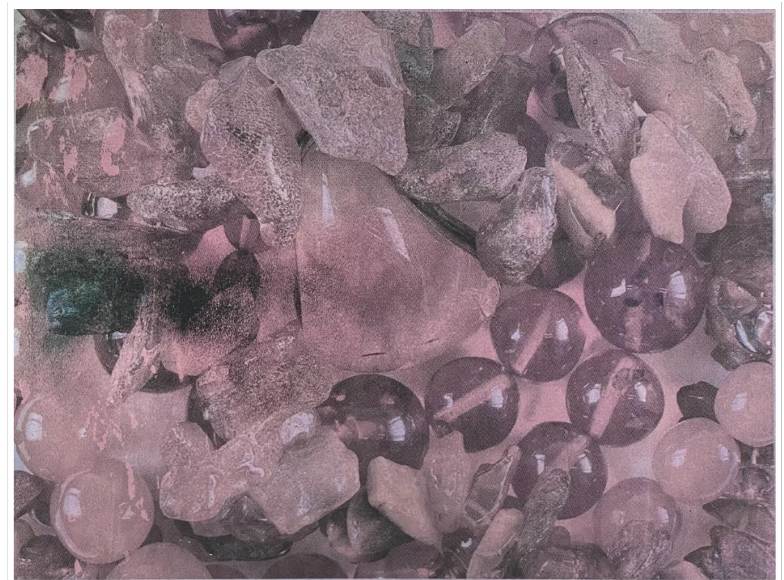
Figure A8. 25LPI, direct litho, Spectraval™ pigments, B,G,R, black Plike, film negative, print size: 600 mm × 450 mm.